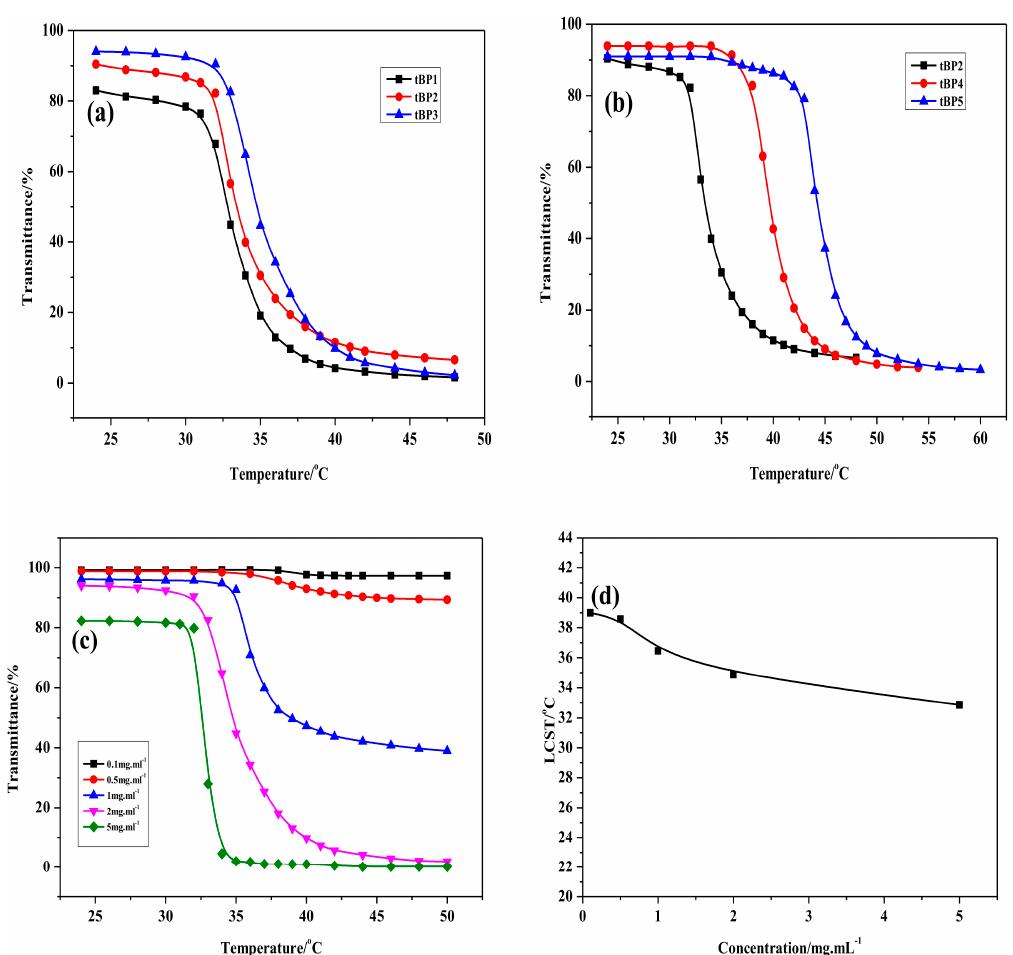
Figure 2. Curves of the triblock copolymers aqueous solutions transmittance versus temperatures with ( a ) different degrees of polymerization, ( b ) the different content of OEGMA, ( c ) different concentrations of tBP3 aqueous solutions, and ( d ) LCST versus the tBP3 concentration.